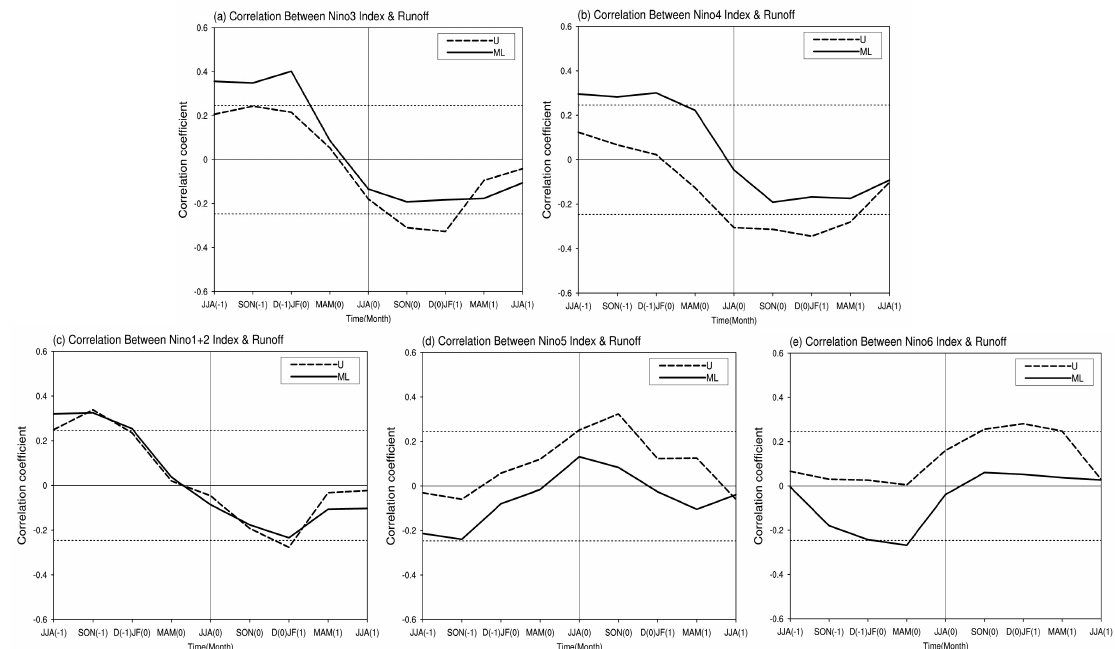
Figure 6. The lead–lag correlation coefficients between the upper and mid-lower reaches runoff time series in Figure 3 and the ( a ) Niño3, ( b ) Niño4, ( c ) Niño1+2, ( d ) Niño5, and ( e ) Niño6 indices from June–July–August (JJA) (−1) to JJA (1). The two horizontal lines represent the 95% confidence level based on Student’s t -test. The vertical line indicates JJA (0), where the simultaneous correlations between the two runoff series and El Niño–Southern Oscillation (ENSO) indices are shown.